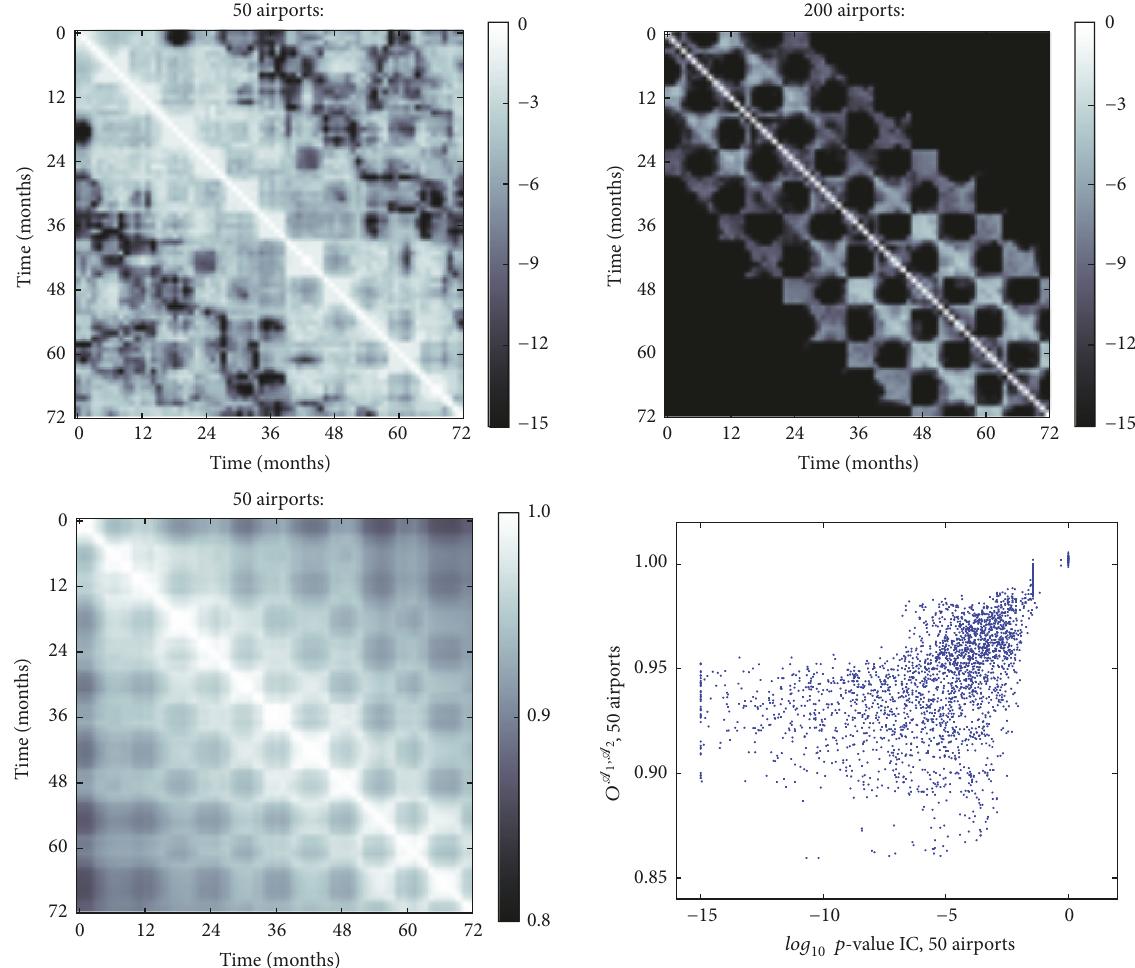
Figure 4: Analysis of the world-wide air transport network. (Top) Evolution of the structure of changes, for the top- 50 (left panel) and top- 200 (right panel) networks. The colour of each point represents the log 𝑝 -value of the 𝐼𝐶 test, with light (dark) shades indicating 10 of the random (structured) changes. Bottom left: evolution of the structure, for the top- 50 networks, as yielded by the normalised global overlap 𝑂 . Bottom right: scatter plot comparing the results yielded by the 𝐼𝐶 and 𝑂 , for the top- 50